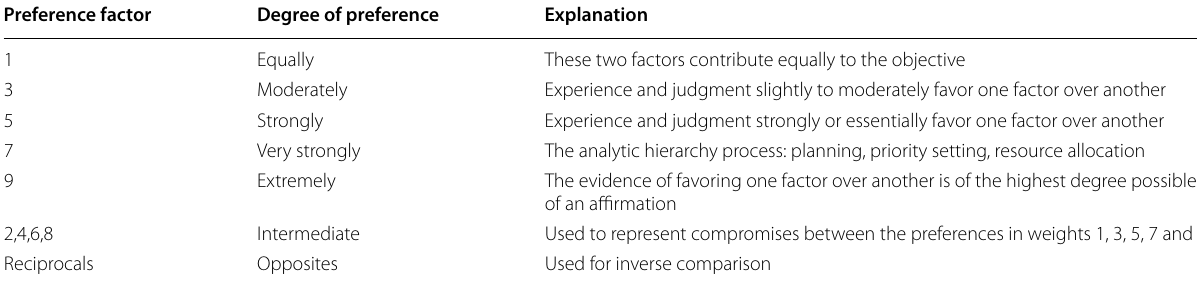
Table 2 The scale and its description (modified from Saaty 1977) Preference